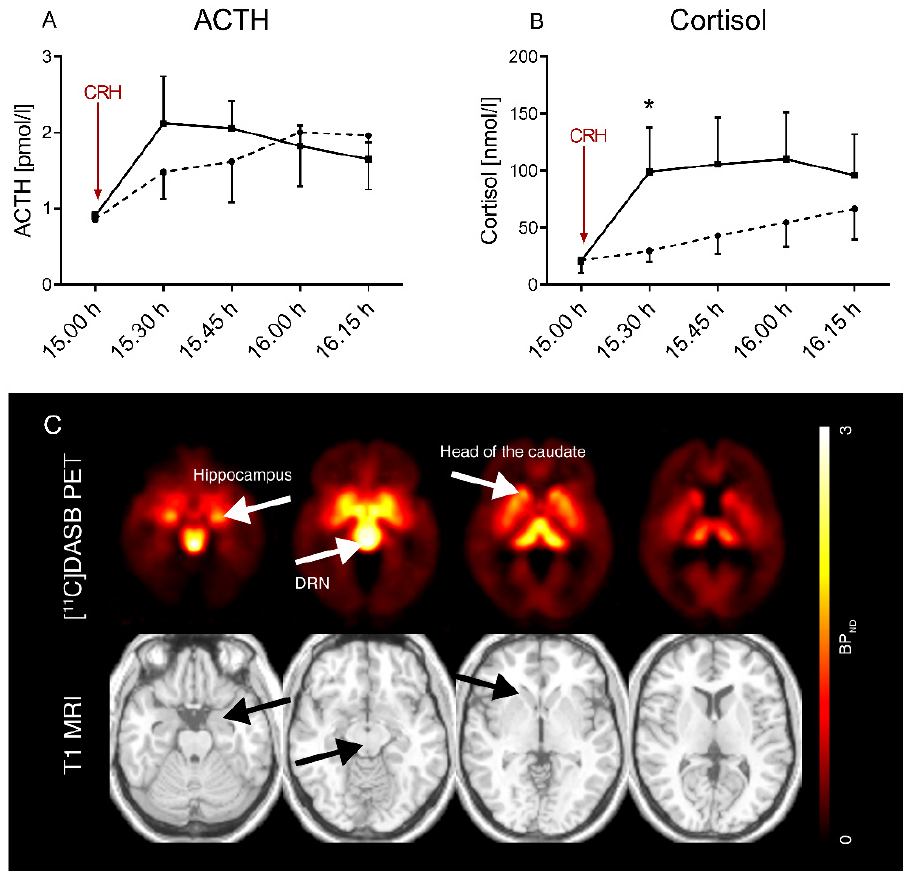
Figure 1. HPA axis responsiveness in the course of time and average parametric [11C]DASB PET imaging. Time course of HPA axis responsiveness by ACTH ( A ) and cortisol response ( B ) to the combined dex/CRH test in individuals with obesity ( n = 28; squares, solid line) and non-obesity controls ( n = 12; circles, dashed line). After 1.5 mg dexamethasone, taken orally at 23.00 h the night before testing, 100 µ g CRH were applied i.v. at 15.02 h. Post-CRH cortisol (which was 30 min after CRH stimulation, taken at 15.30 h) was significantly higher in OB (marked with *, p = 0.01). Data are given as mean with 95% confidence interval. Shown are individuals who also underwent [ 11 C]DASB PET; full sample ( n = 39 vs. n = 22 available in [10]). dex, dexamethasone; CRH, corticotropin-releasing hormone; ACTH, adrenocorticotropic hormone. ( C ) Averaged parametric [ 11 C]DASB PET image of the entire cohort with a single participant’s T1 MRI (taken from Statistical Parametric Mapping toolbox) in MNI space. DRN: dorsal raphe